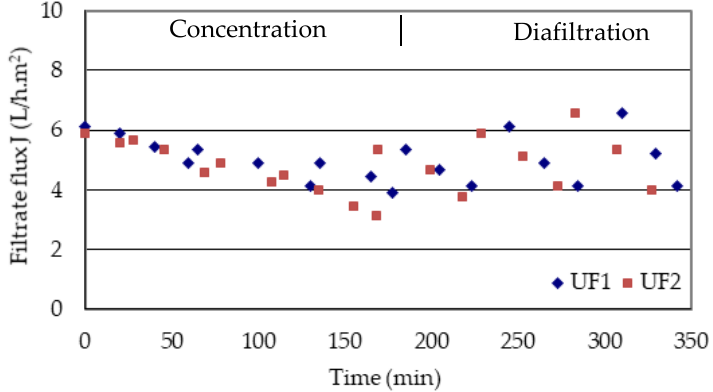
Figure 2. Permeate flux kinetics during UF and diafiltration of both replicates (UF 1 and UF 2 ) of the studied grape seed extract (GSE) by the 10-kDa MMCO membrane (P TM 0.5 bar, temperature 15–26 °C).